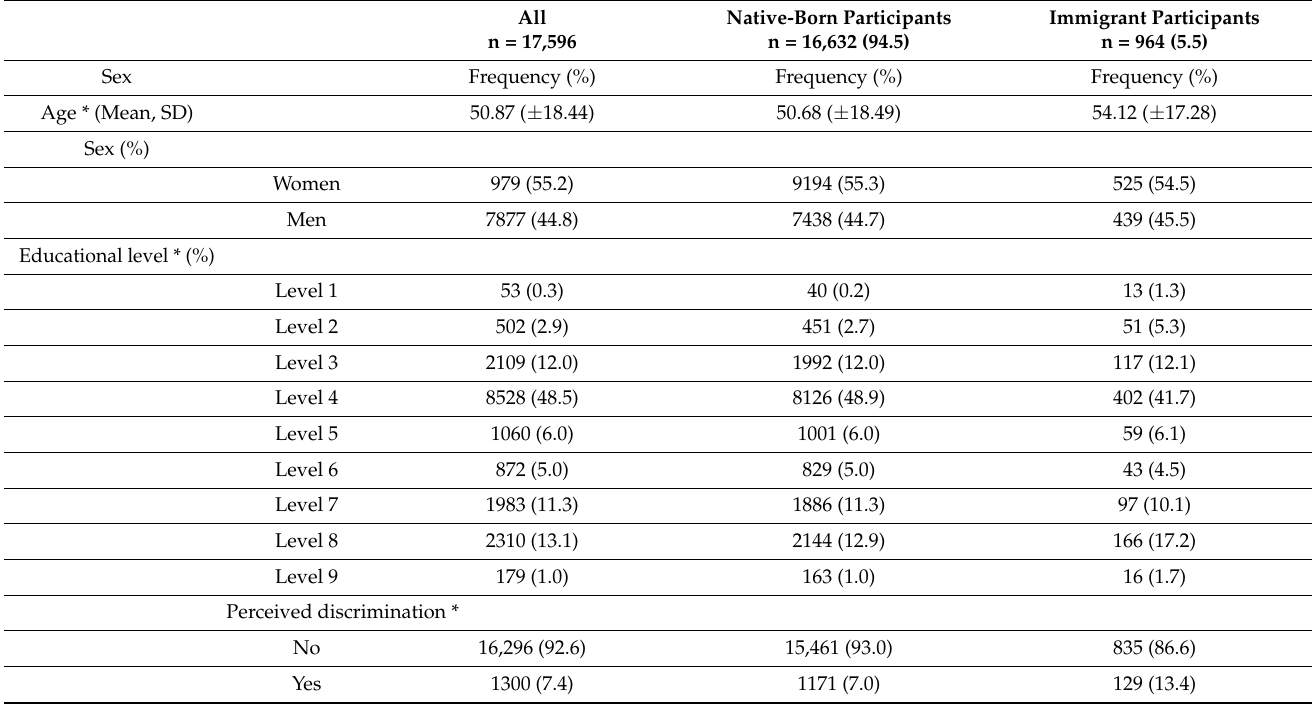
Table 1. Distribution of demographic factors overall and by immigration